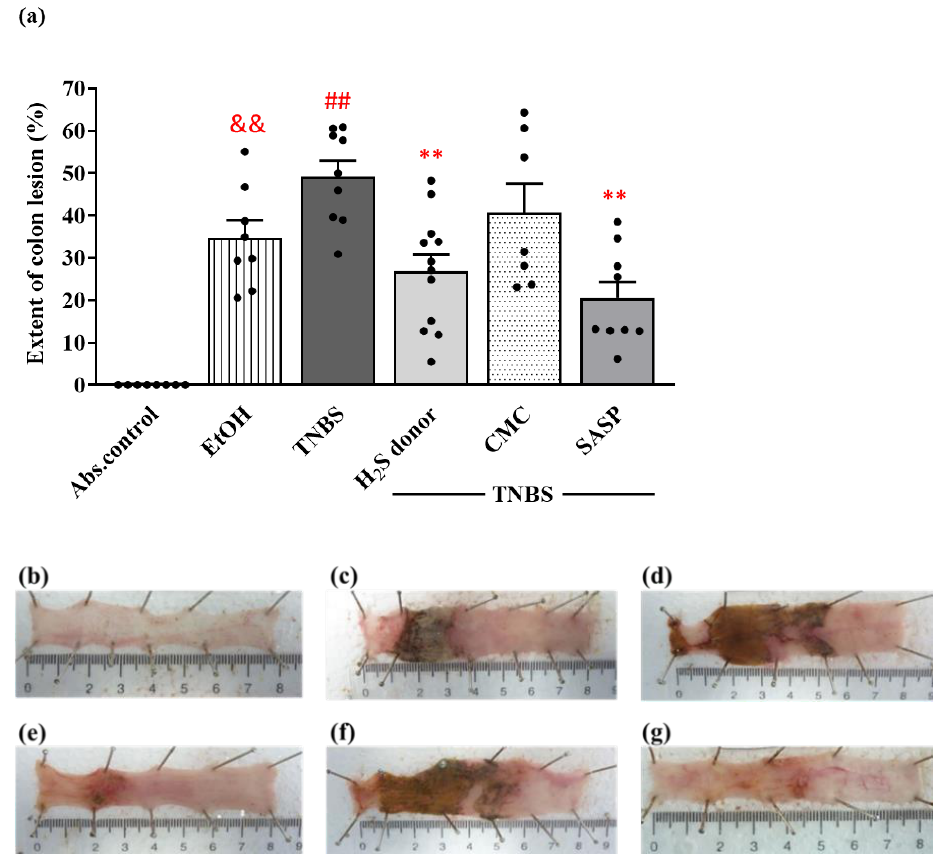
Figure 1. ( a ) The extent of colonic lesion in the different treatment groups in TNBS-induced rat co- litis. Representative images of colonic inflammation in the experimental groups: ( b ) absolute control (no treatment); ( c ) EtOH (50% ethanol, the solvent of TNBS); ( d ) TNBS (2,4,6-trinitrobenzenesulfonic treatment); ( c ) EtOH (50% ethanol, the solvent of TNBS); ( d ) TNBS acid enema); ( e ) H 2 S donor (TNBS + 18.75 μM/kg/day Lawesson’ s reagent); ( f ) CMC (TNBS + 0.5%